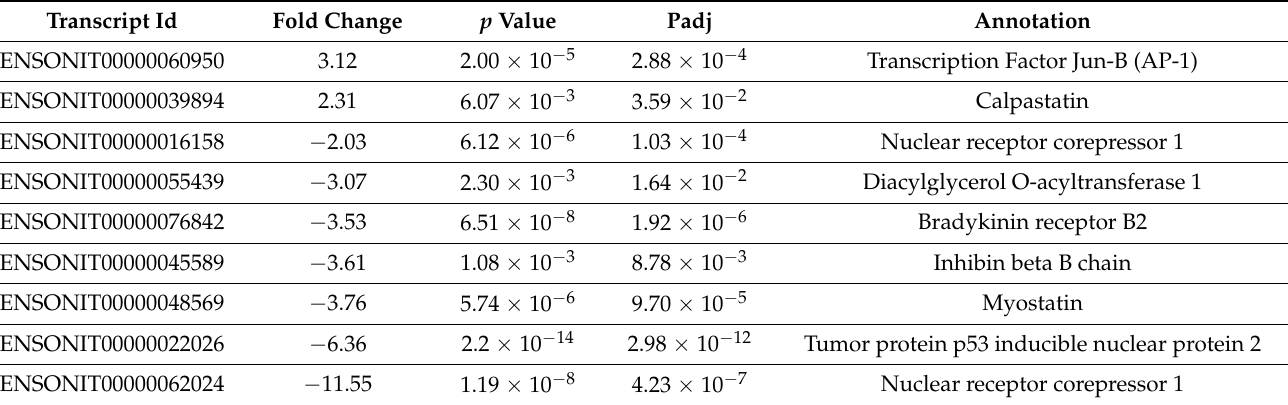
Table 2. Genes associated with skeletal muscle hypertrophy were identified in the tilapia compen- satory growth